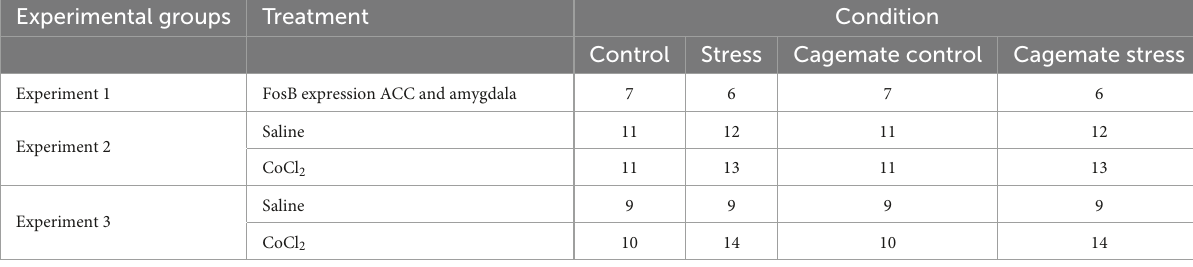
TABLE 2 Sample sizes for each experimental